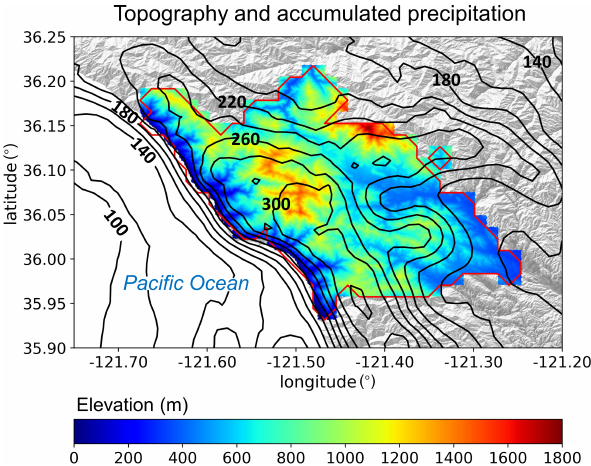
Figure 2. The topography (m; shading) and MRMS accumulated precipitation (mm; contour lines) during the AR event from 27 Jan- uary 00:00 to 29 January 23:00 (all times in this paper are UTC) in the Dolan burn scar. Contour line interval for accumulated precipi- tation is 20mm, and lines of 100, 140, 180, 220, 260, and 300mm are labeled. The red polygon outlines the perimeter of the Dolan burn